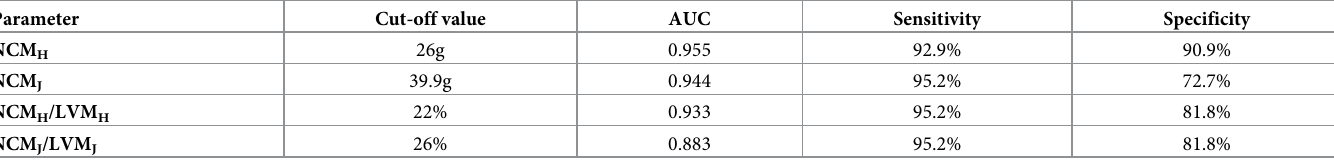
Table 7. The cut-off values of left ventricular noncompaction mass (NCM) between the left ventricular noncompaction group (LVNC) and the control group–ROC analysis. Parameter Cut-off value AUC Sensitivity Specificity NCM H 26g